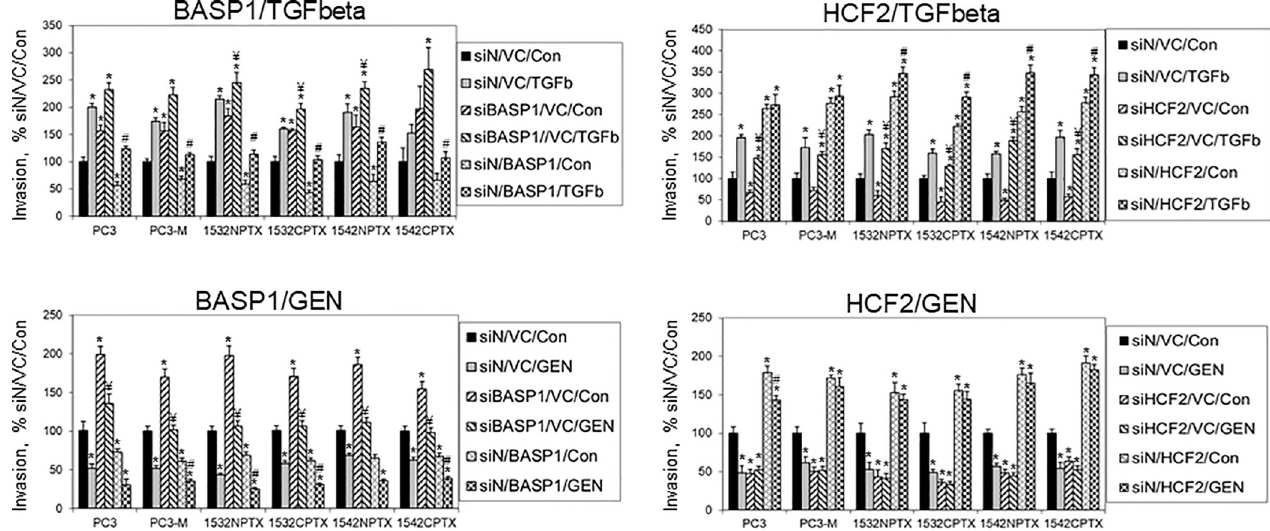
Fig 2. The effect of BASP1 and HCF2 on human prostate cell invasion and genistein efficacy. Each of six different human prostate cell lines, as denoted, were transfected with siRNA to BASP1, HCF2 or non-targeting siRNA (siN), overexpressing vector, vector control (VC), pre-treated with genistein or TGF β , and cell invasion measured. Data are the mean ± SEM cell invasion (N = 4 replicates), expressed as percent of control cells (siN/VC/Con, not treated [vehicle only]).